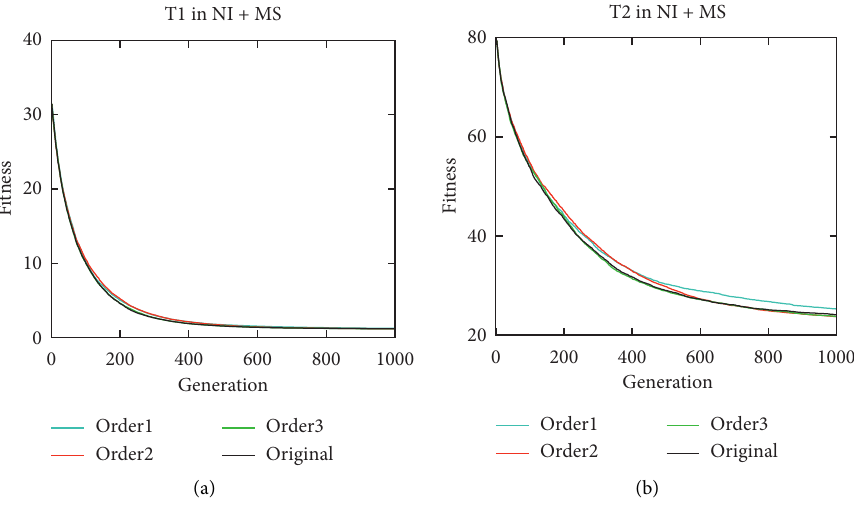
Figure 11: Convergence of MFEA for problem 8